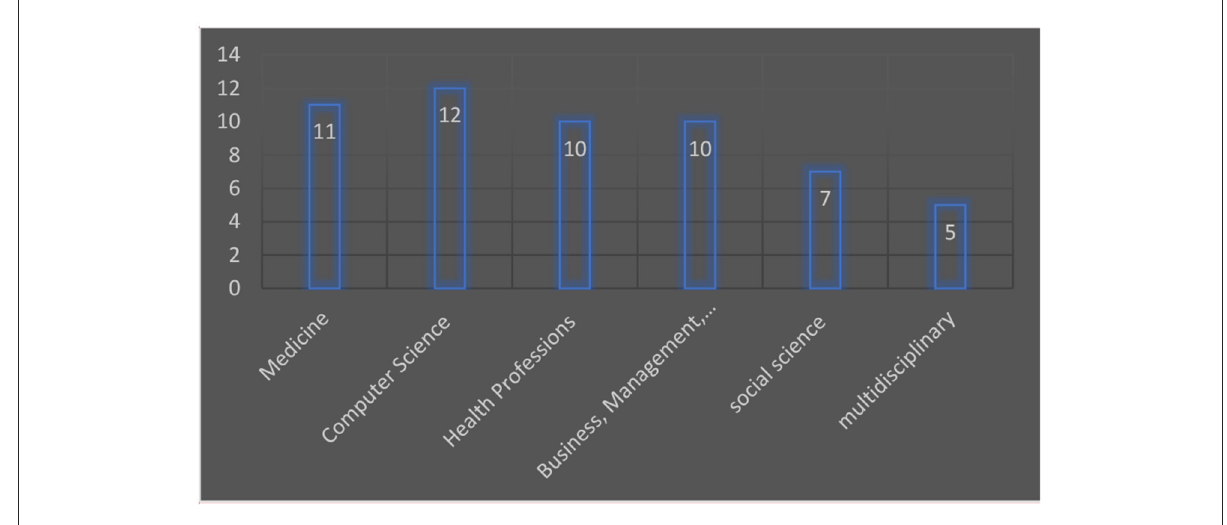
FIGURE2 Showing the results of the